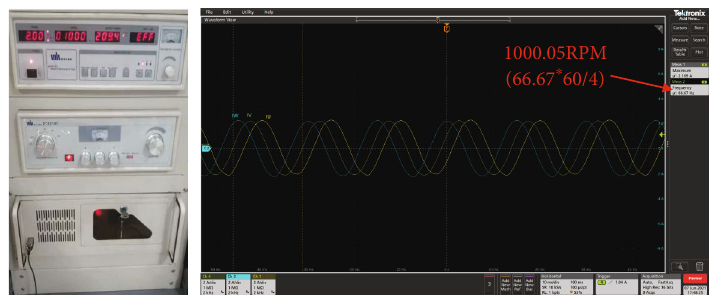
Figure 30: Phase current waveform, torque, and speed measurement for proposed method.